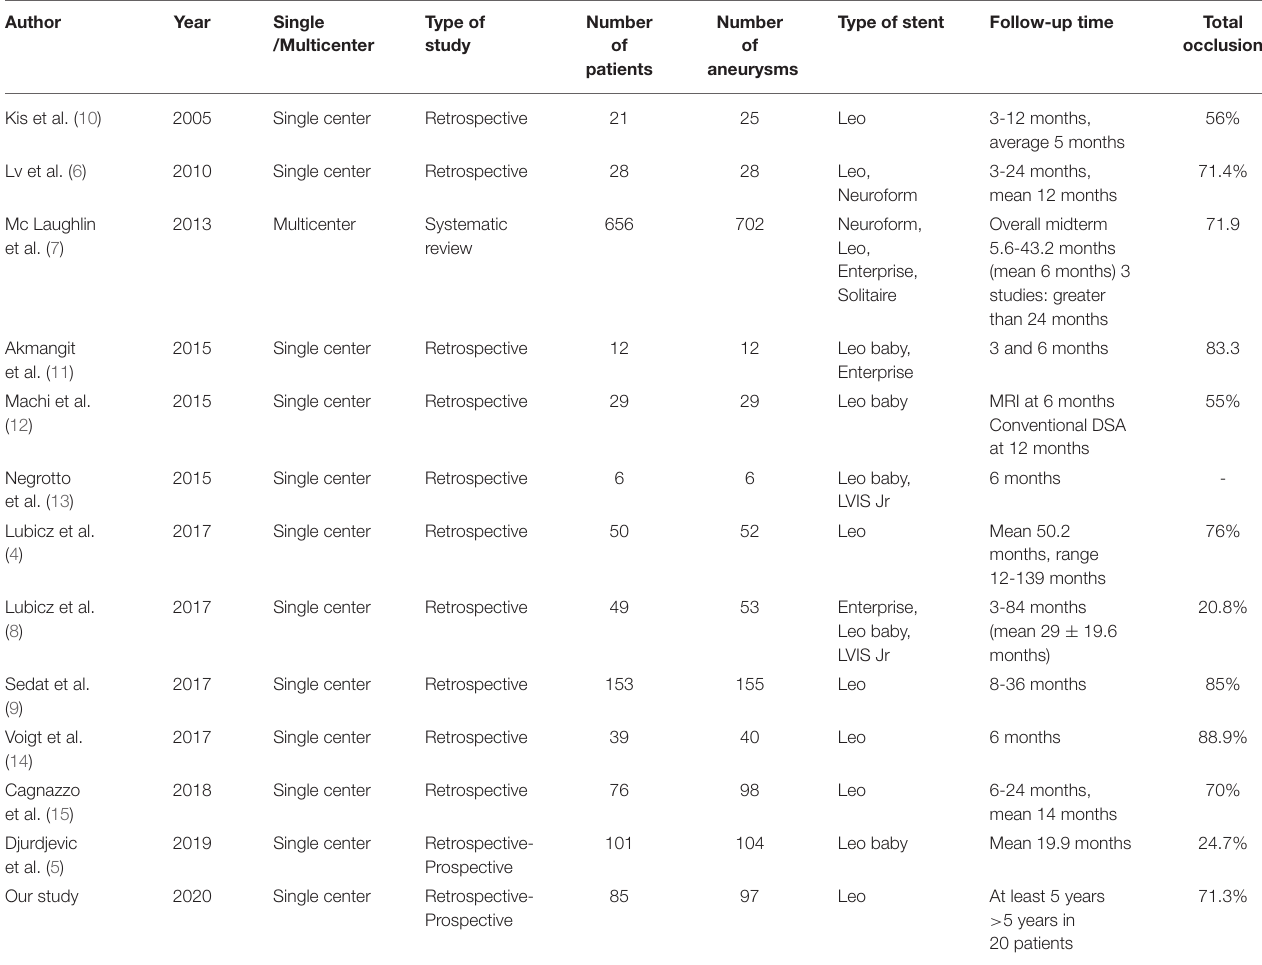
TABLE 4 | Comparison of different studies